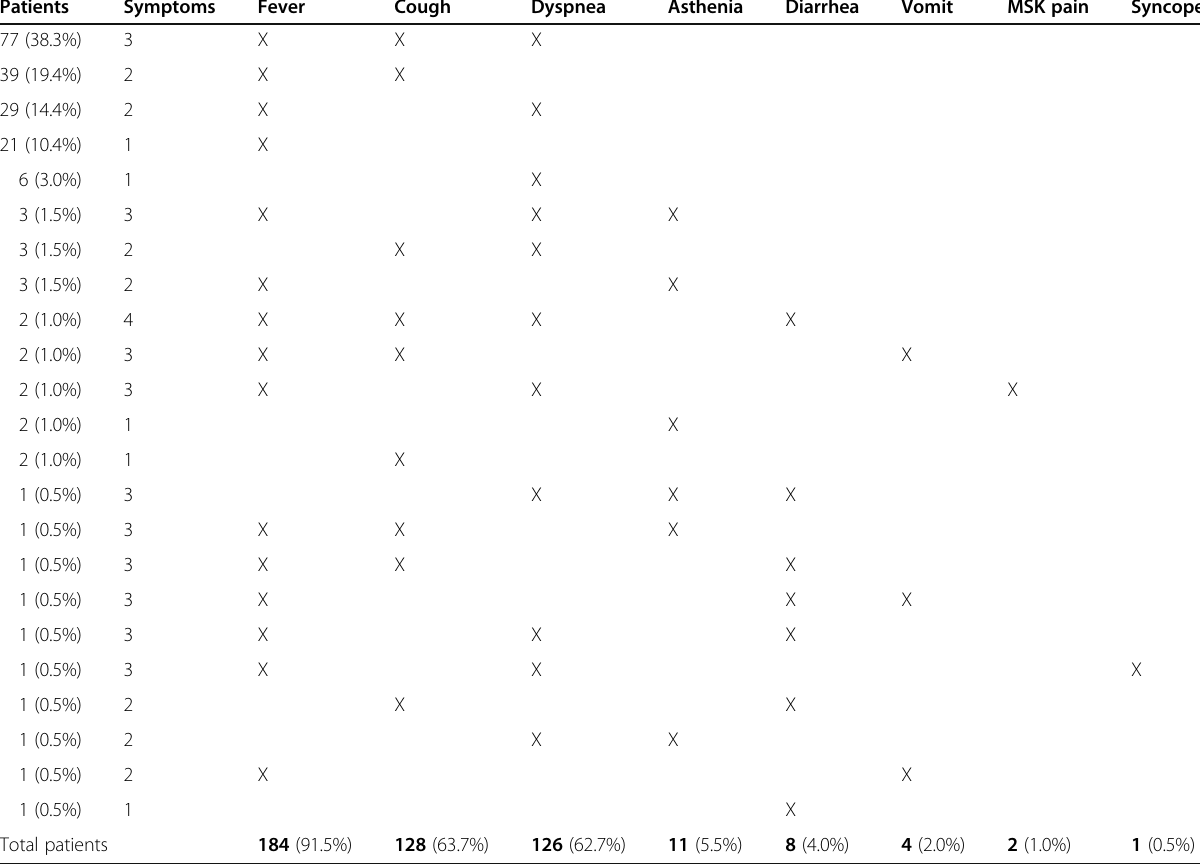
Table 2 Symptoms on admission of the 201 patients from centre 1 Patients